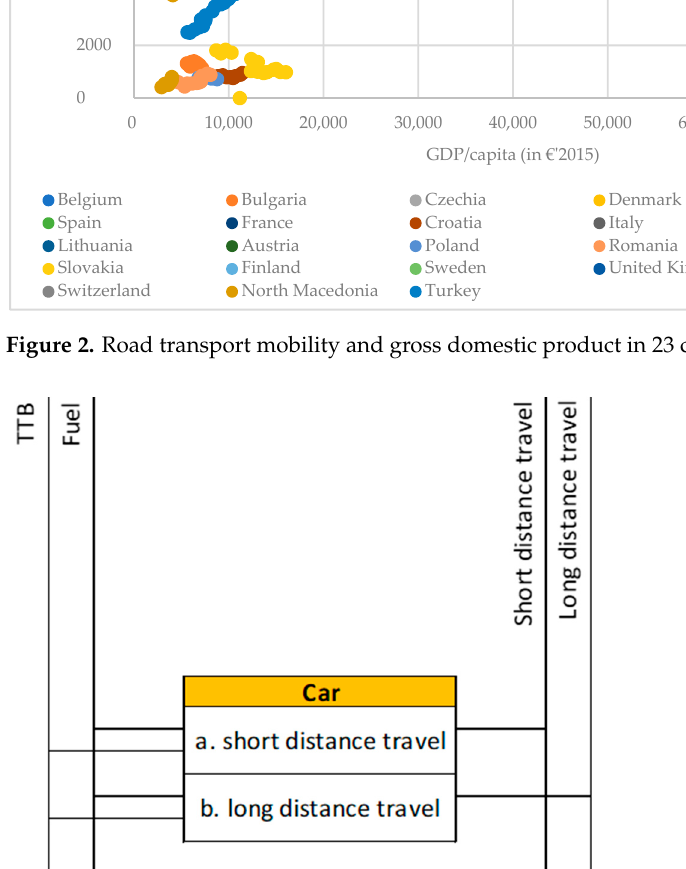
Time consumption rate is calculated with the given Figure 3. A principal diagram of modeling a car in the energy planning model. Fuel economy 𝐹𝐸 (cid:3052),(cid:3033),(cid:3028),(cid:3031) is calculated by dividing the vehicle occupancy rate 𝑂𝑅 (cid:3052) by its fuel consumption rate 𝐹𝐶𝑅 (cid:3052),(cid:3033),(cid:3028),(cid:3031) and multiplying it by 100. Here, the fuel economy is